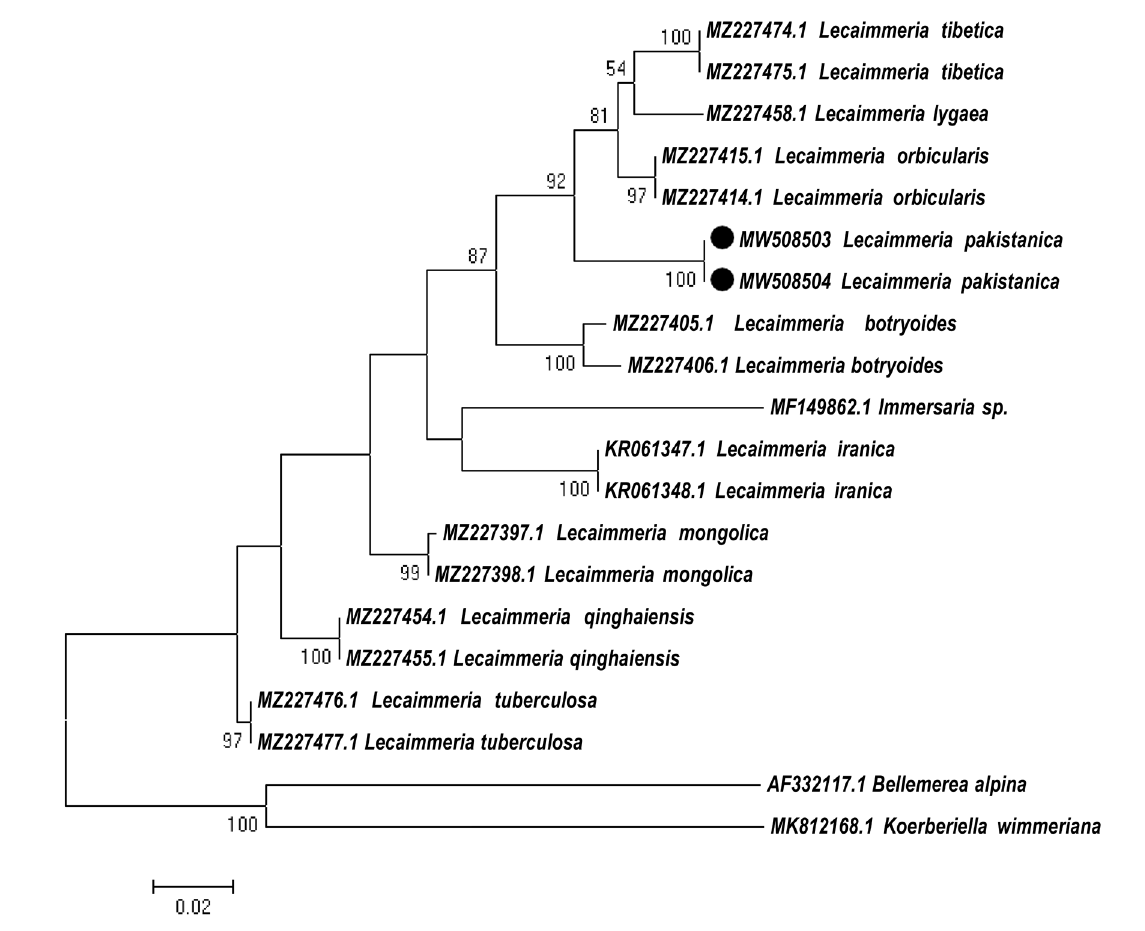
Fig. 1. Molecular phylogenetic analysis of Lecaimmeria pakistanica K.Habib, R.Zulfiqar & Khalid sp. nov. by the maximum likelihood method based on nrDNA sequences, including ITS1, 5.8S and ITS2. Numbers below branch node represent ML bootstrap (> 50%) based on 1000 replicates. Sequences generated from Pakistani collections are marked with black